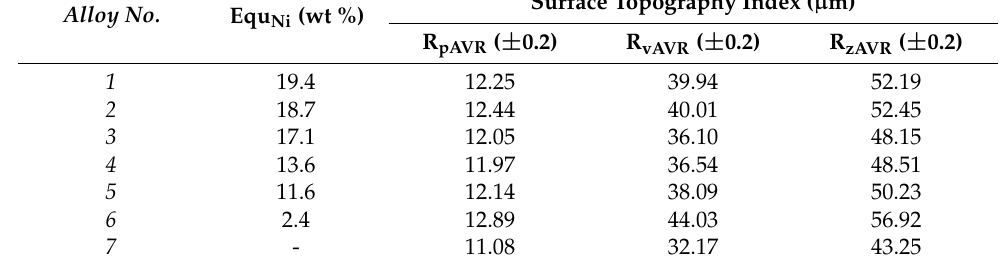
Table 6. Indices describing surface topography of specimens after potentiodynamic tests (after 24-h exposure in 3% aqueous solution of NaCl).